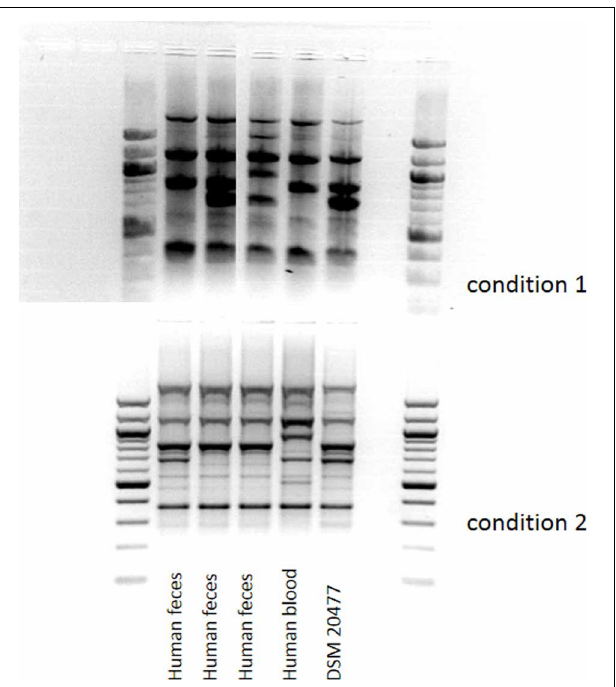
FIGURE 3 | Amplicon-typing (RAPD-PCR, two different conditions) of E. faecalis (MIC of DDAC > 1.4mg/l) from different